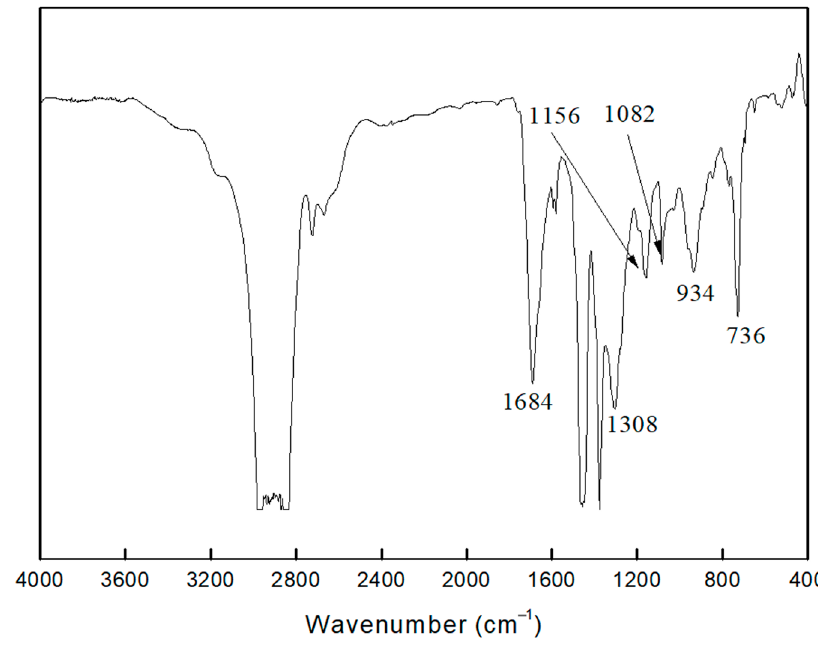
Figure 9. FTIR spectrum of the catalysts.